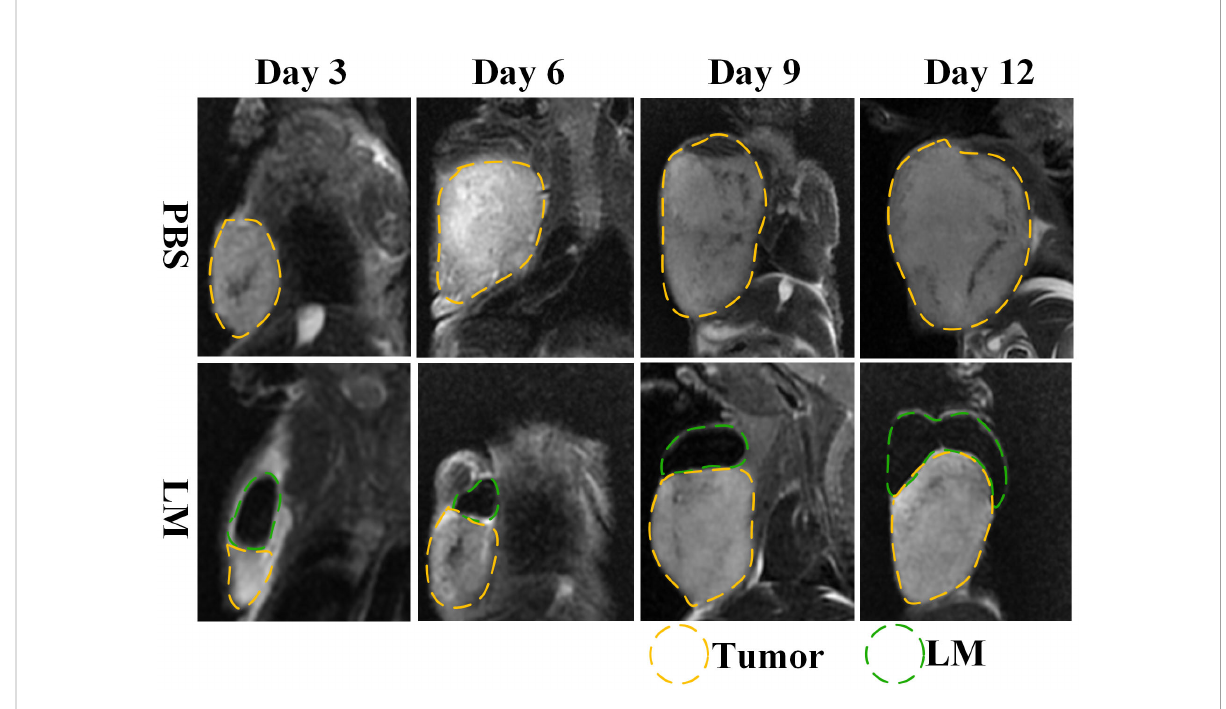
FIGURE 2 MRI T2WI images of PBS group and LM group on different growth days. The LM coverage area is marked with a green dotted line, and the tumor area is marked with a yellow dotted line. LM, liquid metal; PBS, phosphate buffer saline.